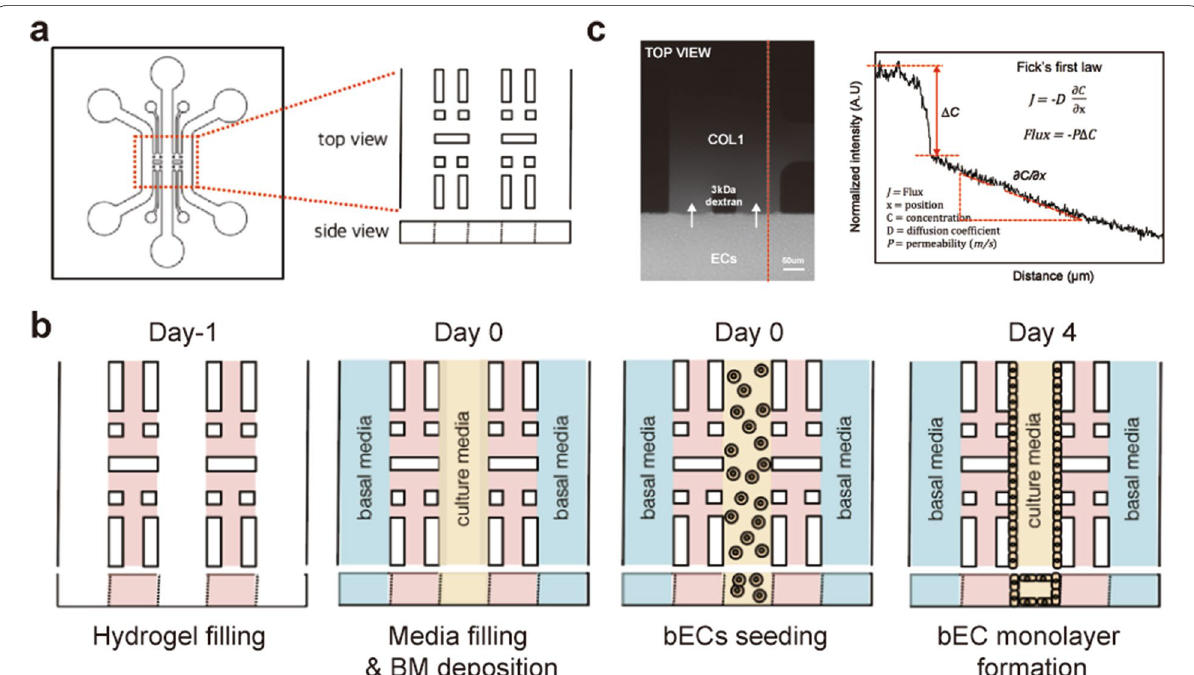
Fig. 1 Schematics of microfluidic device design and permeability assay. Schematic overview of microfluidic chip at top and side view ( a ) and the preparation procedures for brain endothelial monolayer model in the microfluidic device ( b ) were shown. c Represents fluorescence image after injecting dextran into the device and intensity profile for permeability